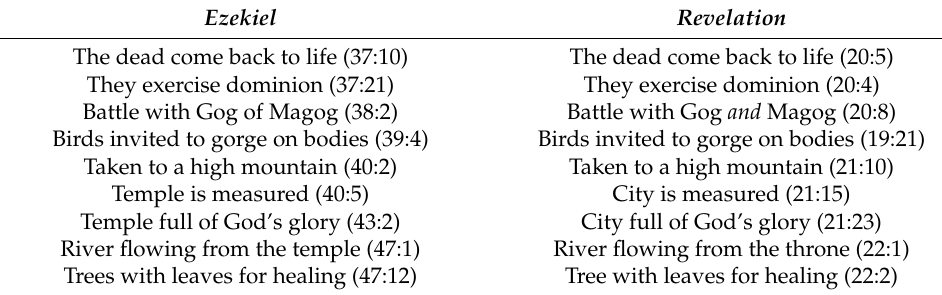
Table 1. Key parallels between Ezek 37–47 and Rev 20–22.